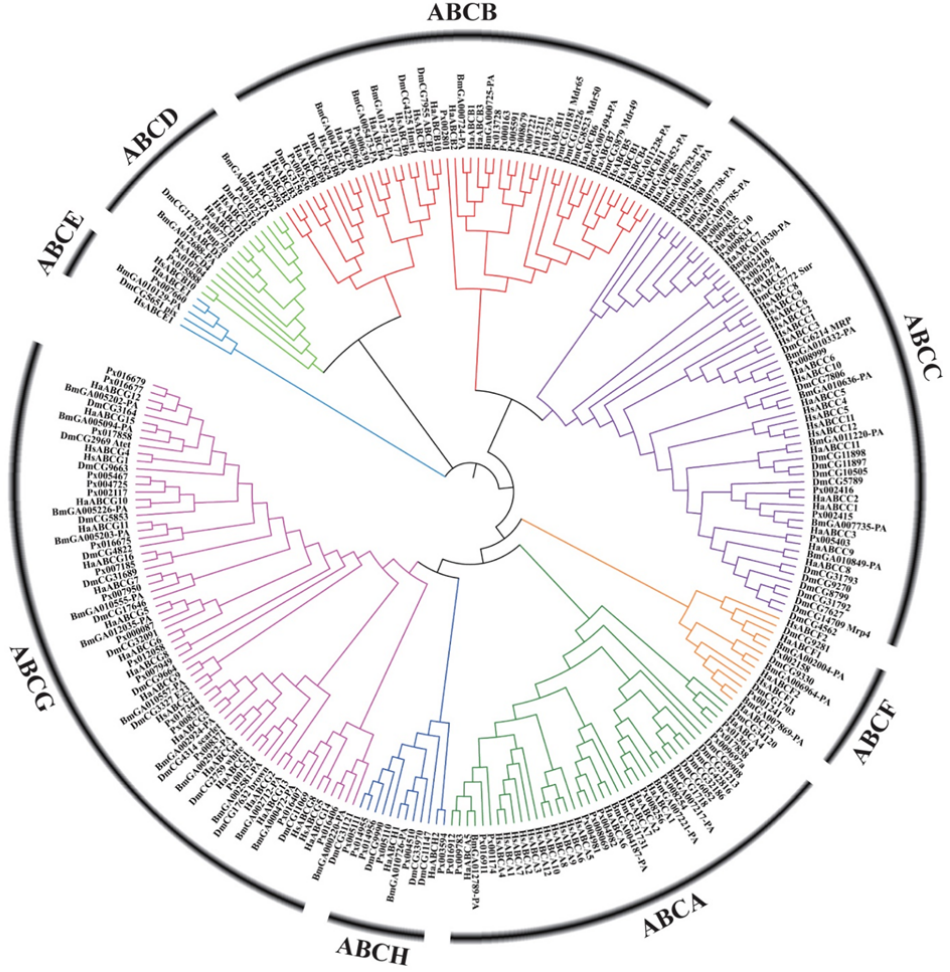
Figure 2. Phylogenetic tree based on amino acid sequences of 262 ABC transporters (Supplementary Material 1) from several insects and humans. The sequences were aligned using